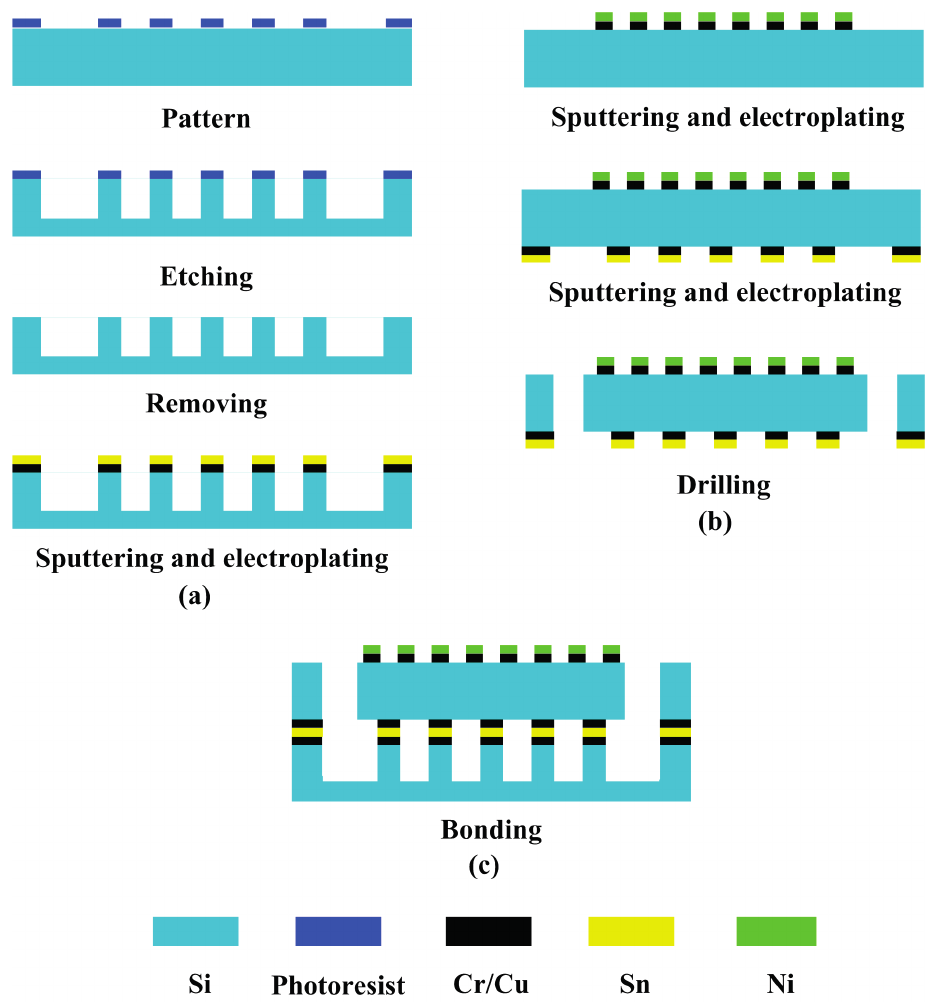
Figure 3. Main fabrication process of the microfluidic heat sink with variously-shaped